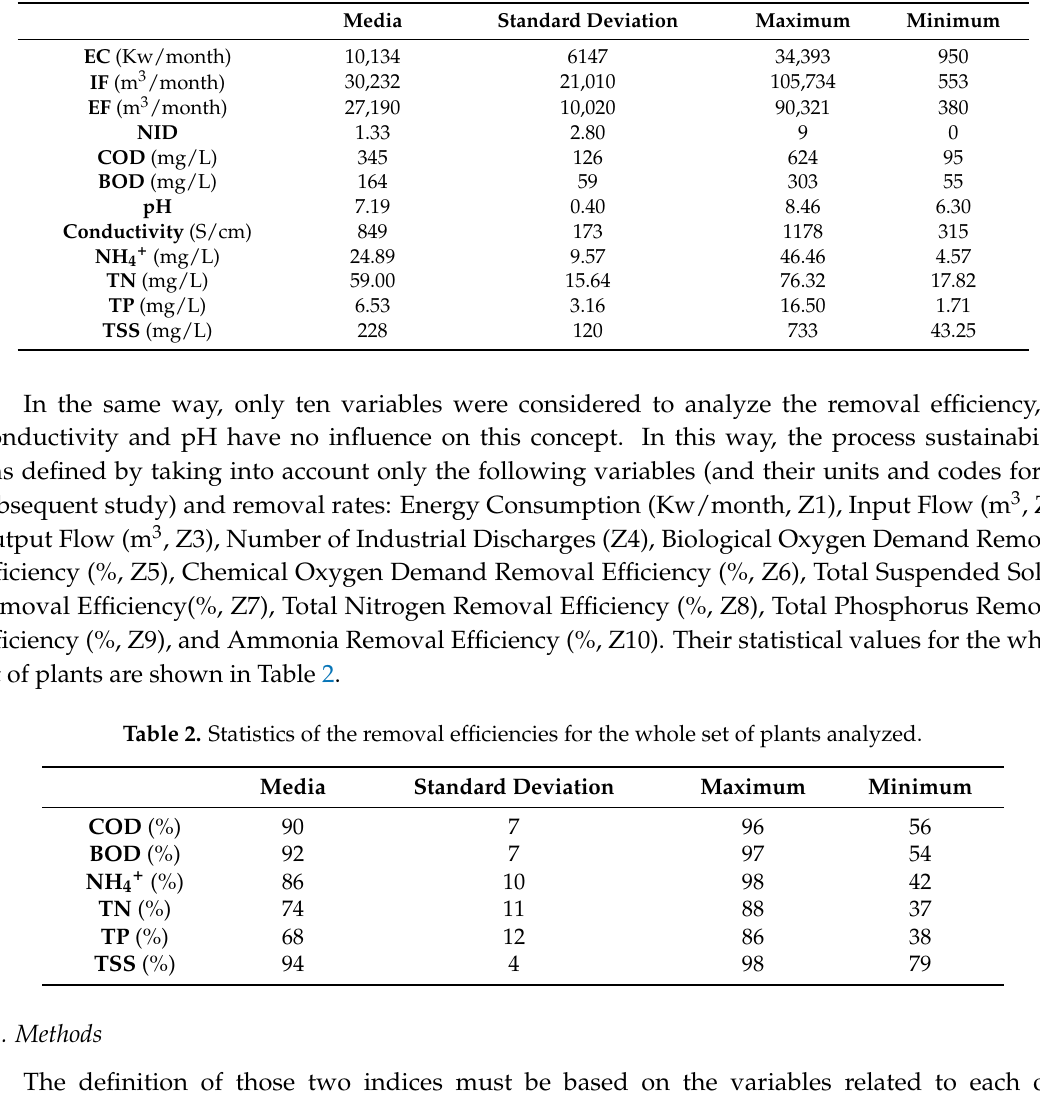
Table 1. Statistics of variables recorded from the whole set of plants analyzed.